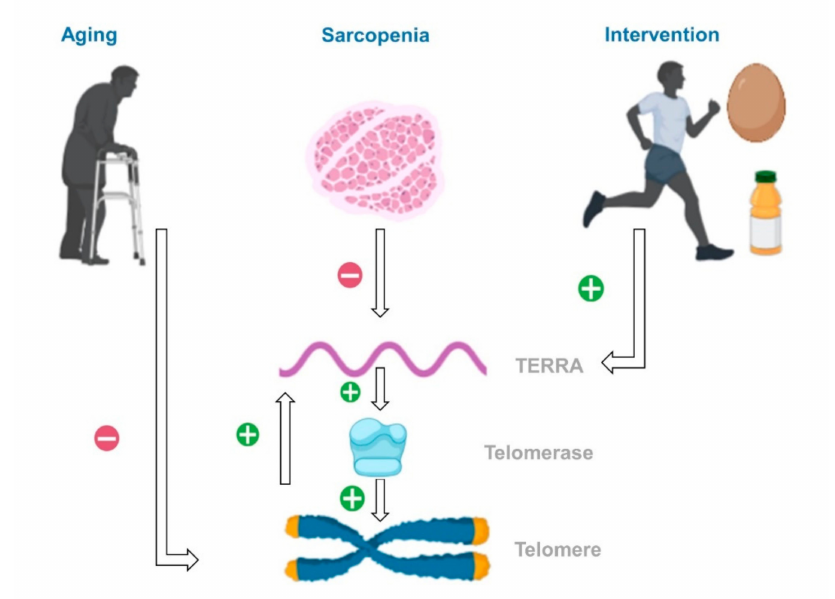
Figure 4. A plausible pathway illustrating how aging, sarcopenia, and intervention using exercise and nutrition a ff ect the telomere and telomeric repeat-containing RNA